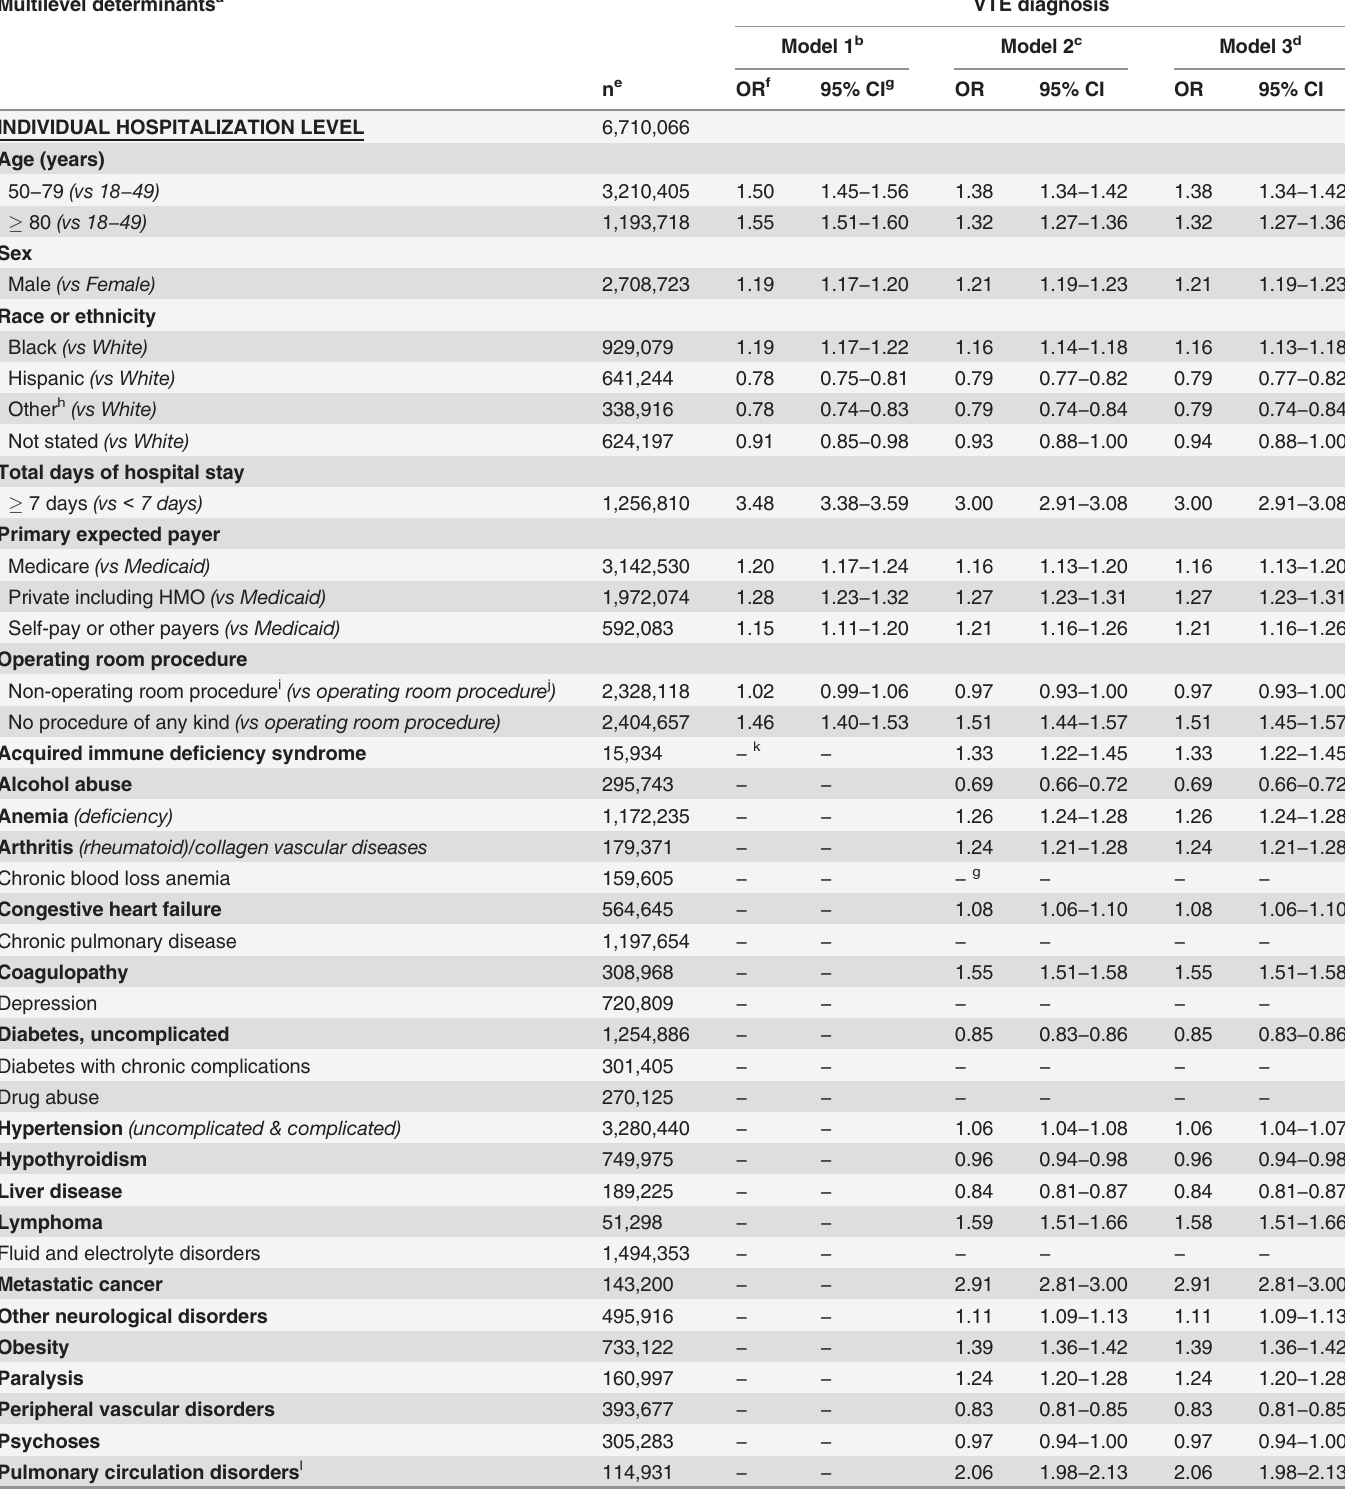
Table 2. Adjusted odds ratios for VTE diagnosis among hospitalizations of US adults by multilevel determinants, NIS, 2011. Multilevel determinants